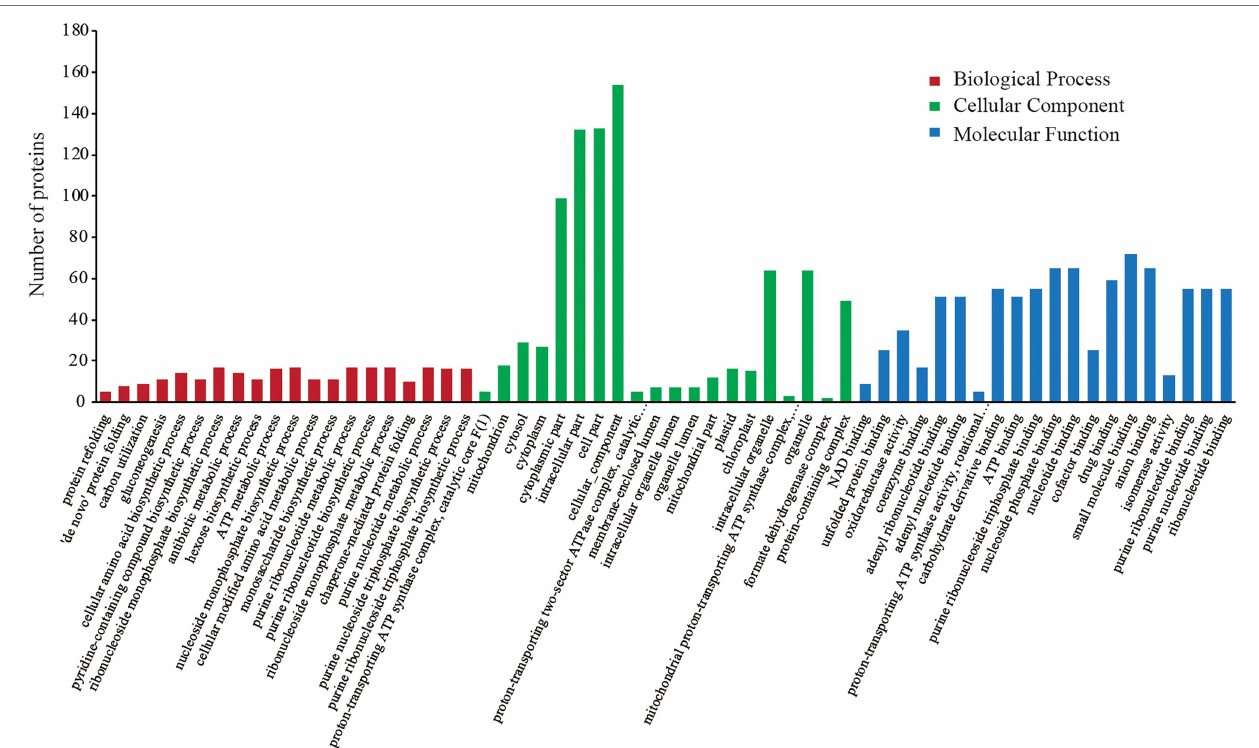
FIGURE 2 | GO annotation analysis of differentially expressed proteins